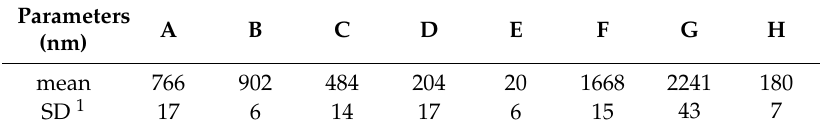
Table 1. Dimensional measurements of parameters in Figure 4 that define the MSPRS architecture.